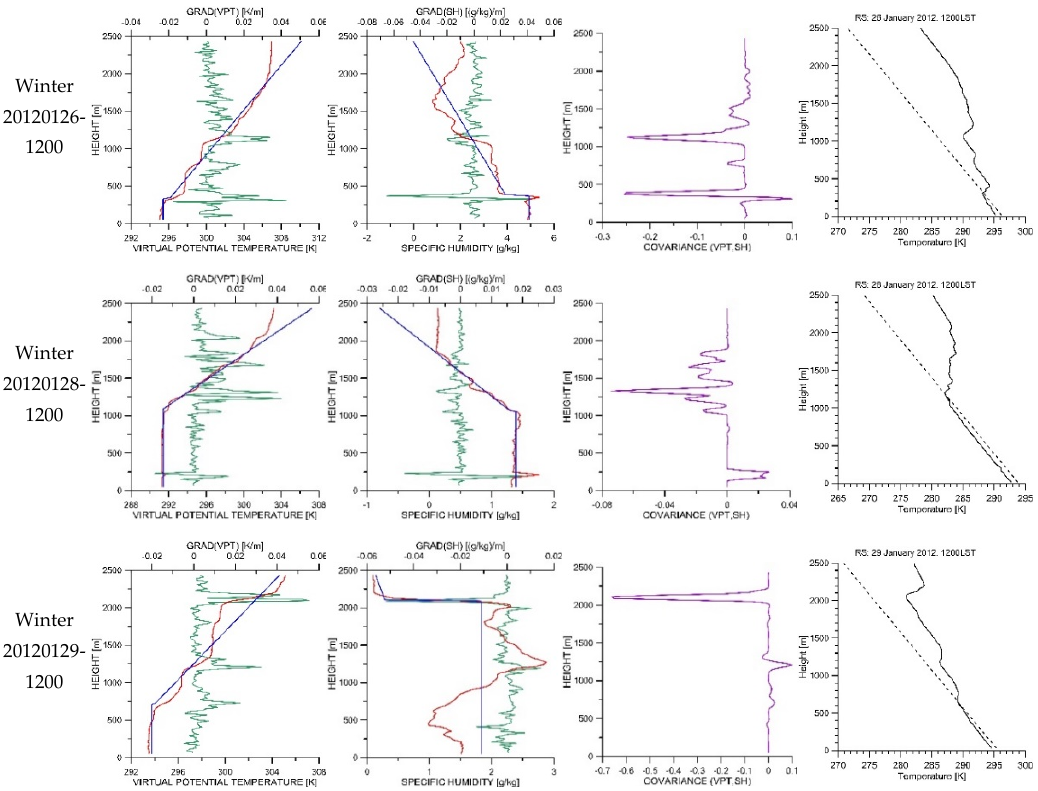
Figure 8. Application of the LSVA, GM, CM, and PM to the VPT, SH, and T profiles of the 12:00 LST of the days 26, 28, and 29 of January 2012. First column: LSVA/VPT and GM/VPT. Second column: LSVA/SH and GM/SH. Third column: CM. Fourth column: PM.